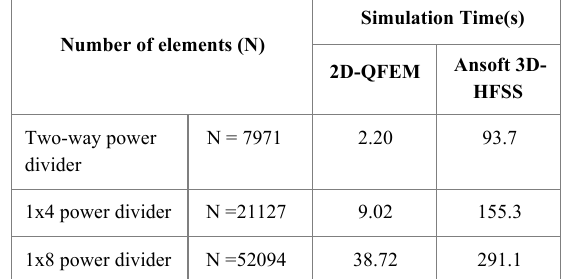
FIGURE 9. Results of the Eight-way SIW power divider obtained between QFEM and HFSS, (a) Reflection coefficients S11 and (b) Transmission coefficients S1i..